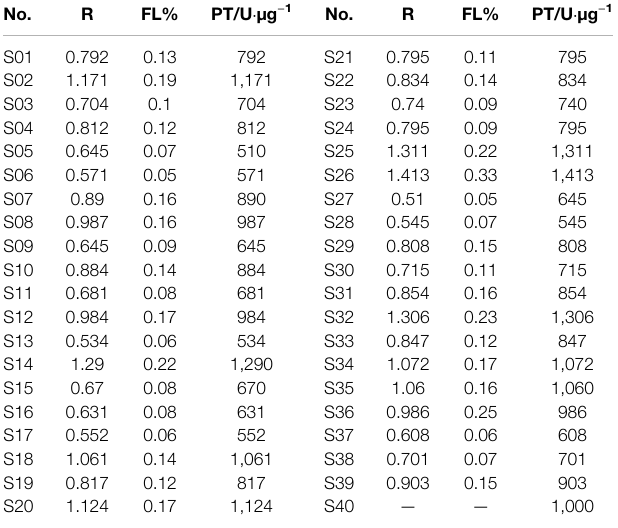
TABLE 3 | The COX-2 inhibition biopotency result of LHQWC.